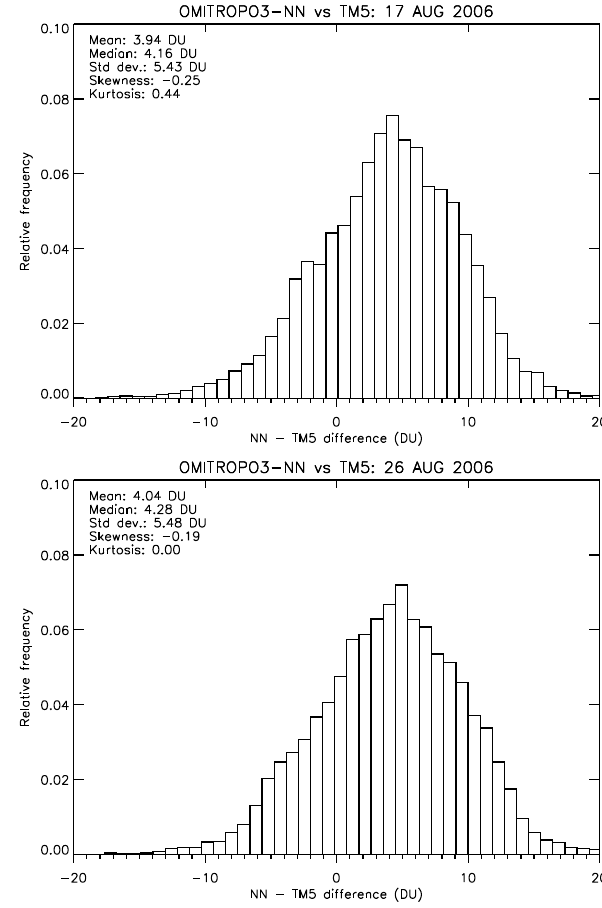
Fig. 13. Scatter plots of the OMITROPO3-NN retrievals versus the TM5 TCO simulations on 17 (top) and 26 August (bottom) 2006. The OMITROPO3-NN TCO fields are remapped on the TM5 grid.